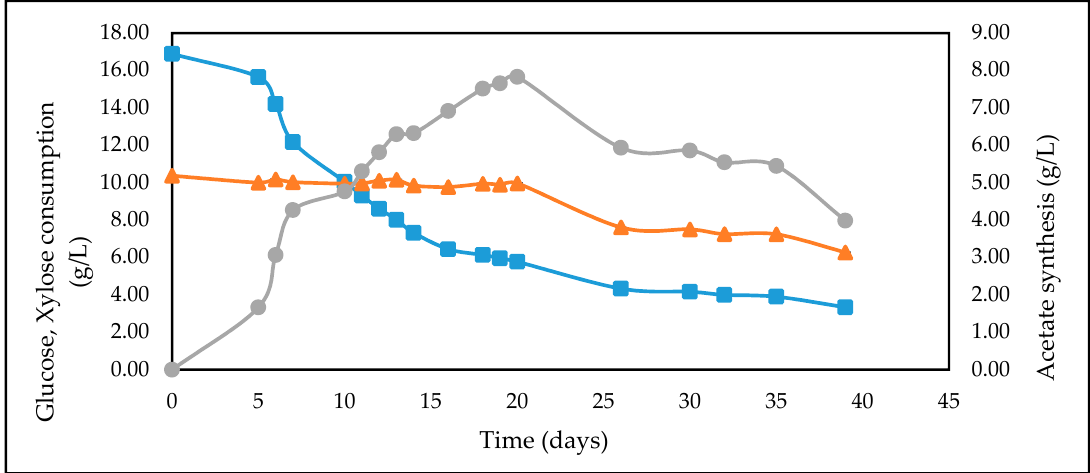
Figure 6. Time-based profile of: glucose uptake (g/L) ( (cid:4) ), xylose uptake (g/L) ( (cid:78) ) and acetic acid production (g/L) ( (cid:108) ) for CSH. (all the standard deviations were less than 5% and cannot be seen in the